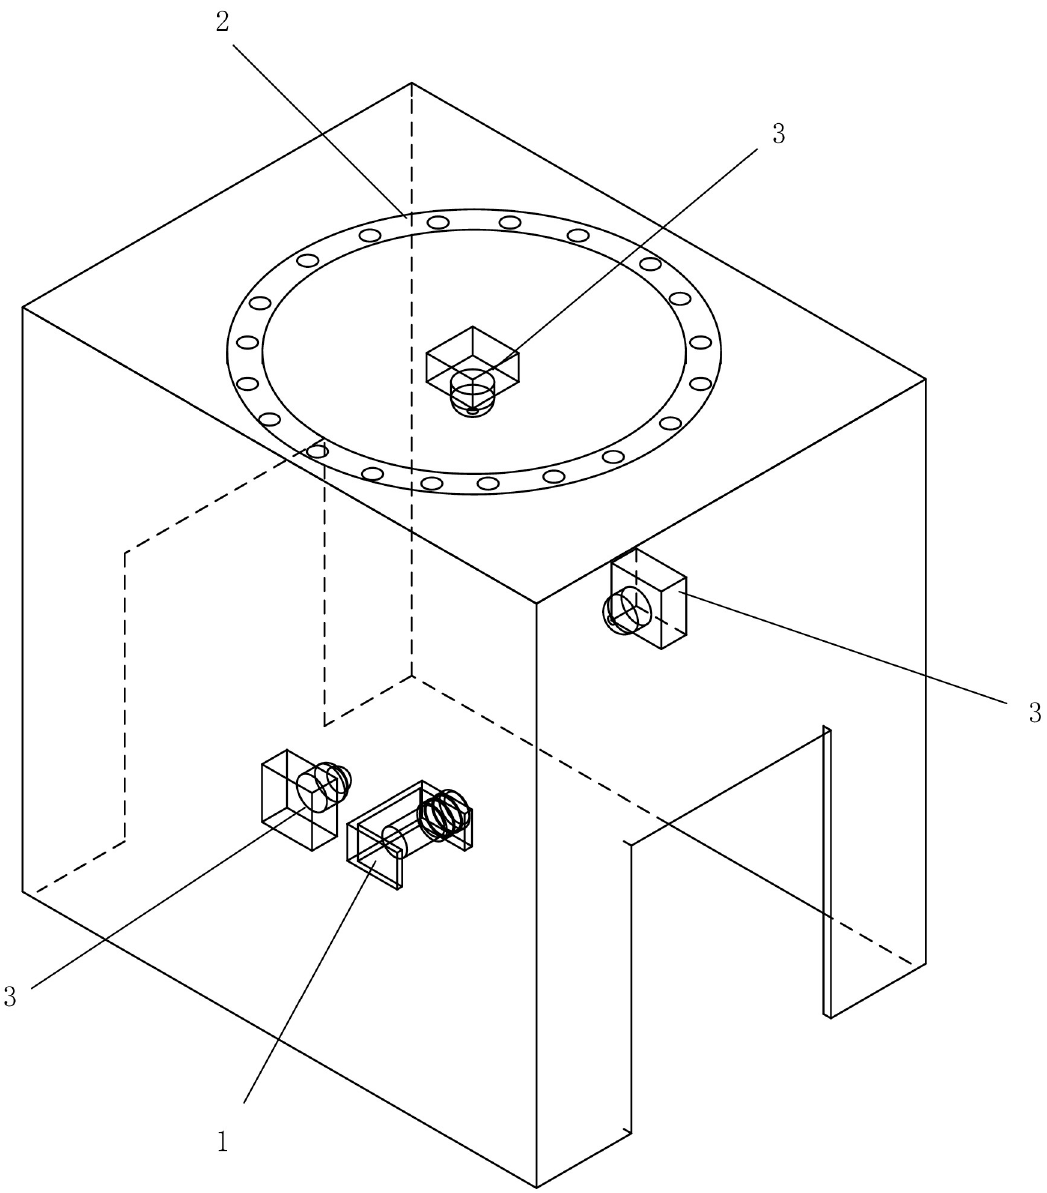
Fig 8. Structure of the visual inspection box. (1. Photoelectric sensor; 2. Ring light source; 3.